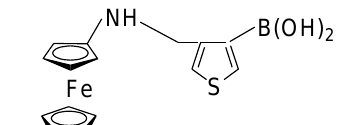
Figure 6. Chemical structure of Fc-substituted thiopheneboronic